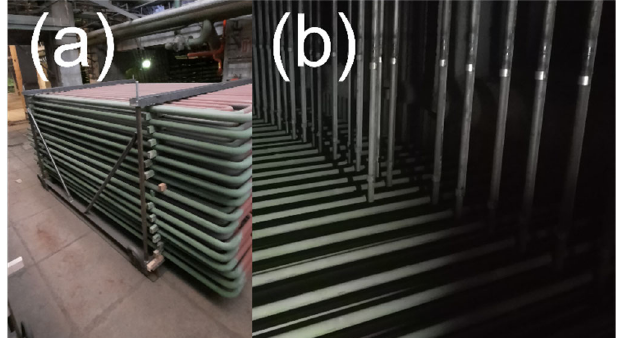
Figure 14. TWAS coating (NiCrMo ‐ based) on a real superheater in a biomass fluid boiler: ( a ) before installation, ( b ) after installation in a boiler.